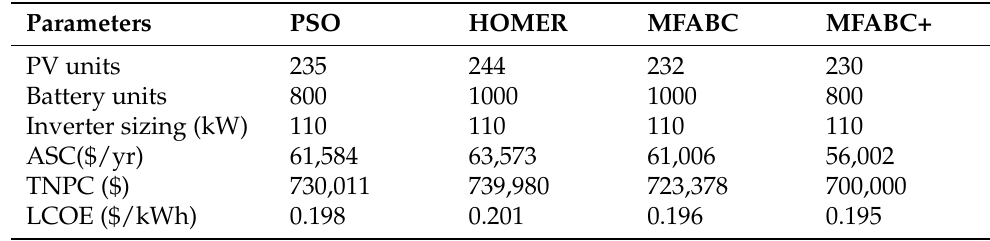
Table 4. Results obtained using all solution